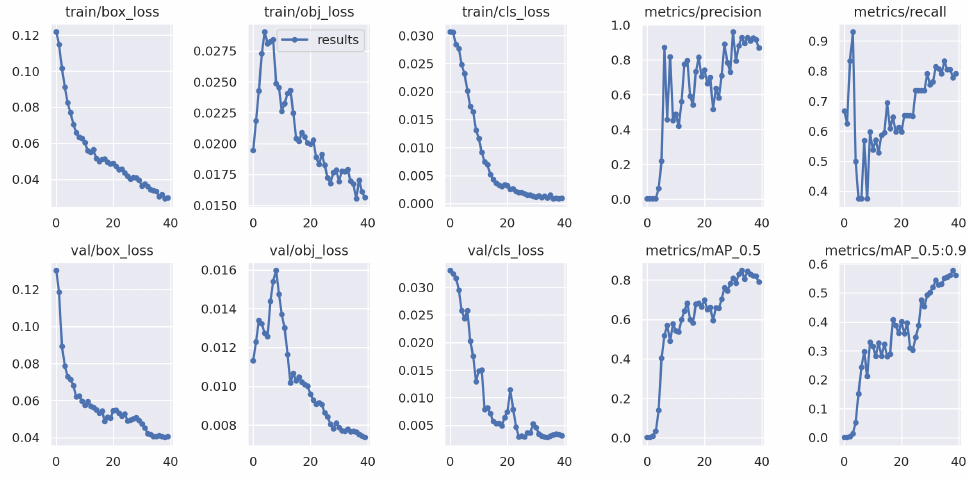
Figure 20. Model evaluation during training on soft rot disease